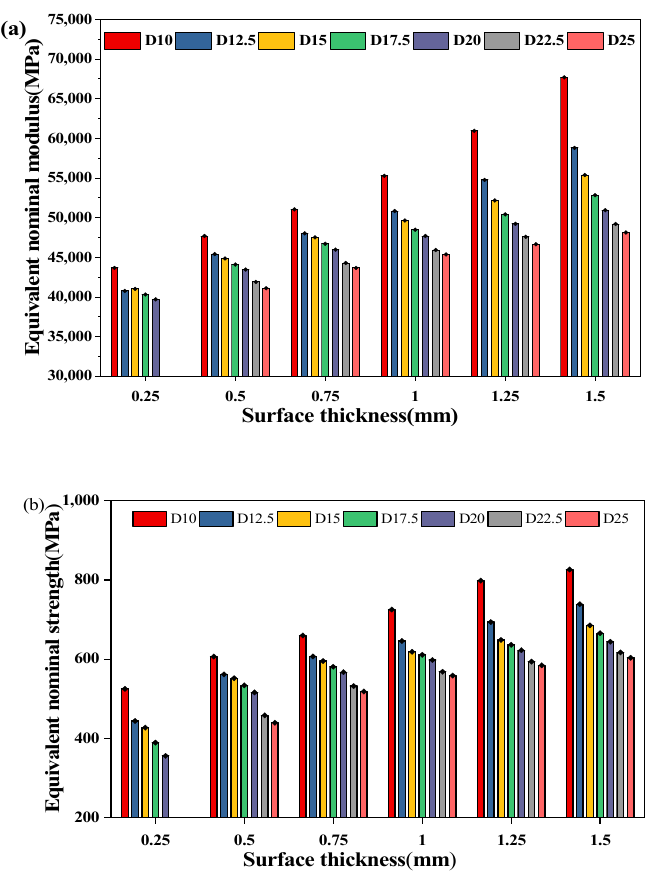
Figure 11. Variations in ( a ) equivalent nominal modulus and ( b ) equivalent nominal maximum strength of the D structure with structural parameters.